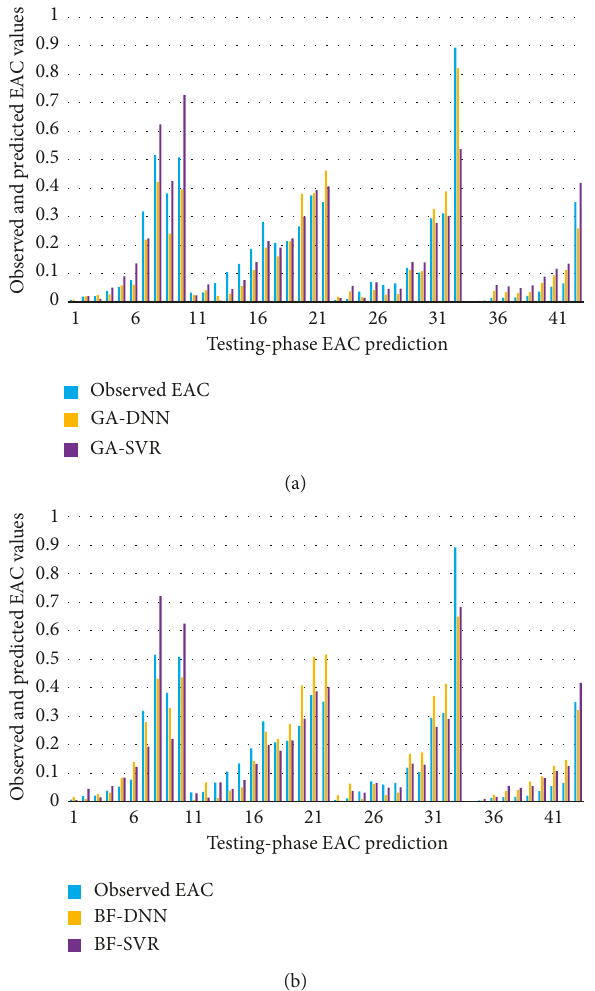
Figure 7: Actual observation of EAC and the optimal combination for (a) GA-DNN and GA-SVR and (b) BF-DNN and